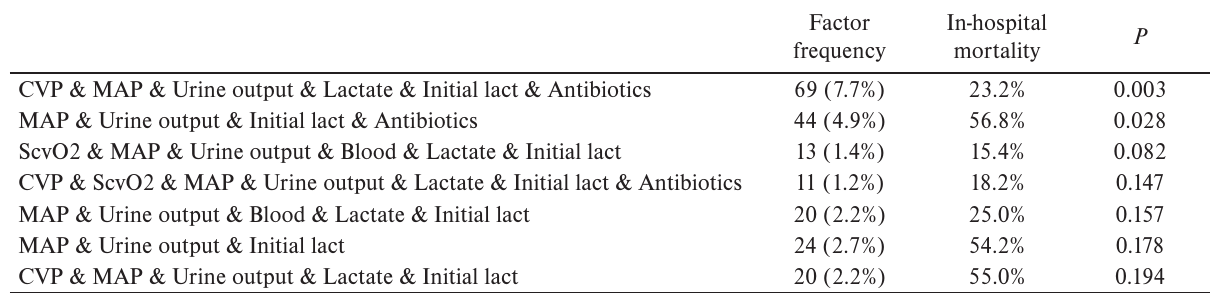
Table 4. Combination of the initial 6 h fulfilled diagnostic/treatment interventions as factors associated with in-hospital mortal- ity: CVP≥8-12 mm Hg (CVP), MAP≥65mm Hg (MAP), Urine output≥0.5 mL/kg/hr (Urine output), Blood culture before